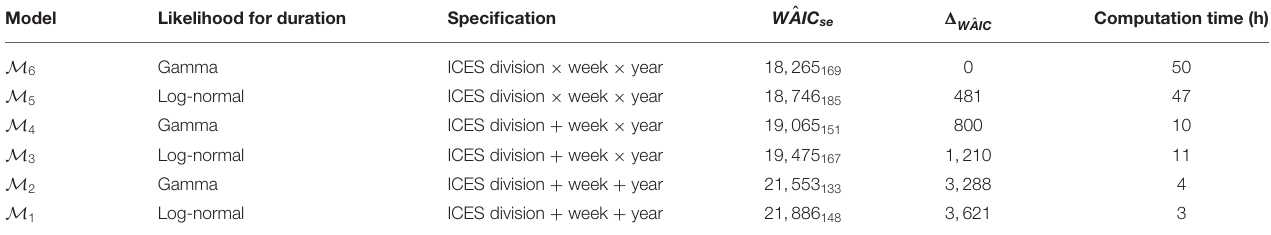
TABLE 4 | Model selection. Model